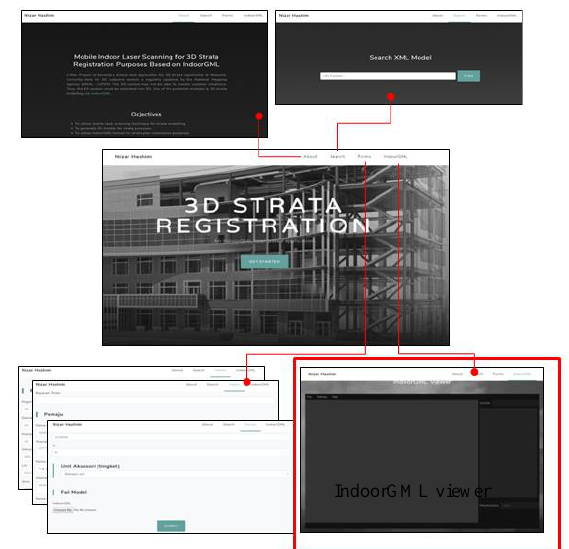
Figure 8. Web-Based user interface design